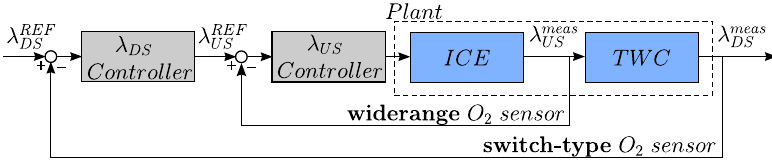
Figure 4. Cascaded air/fuel ratio